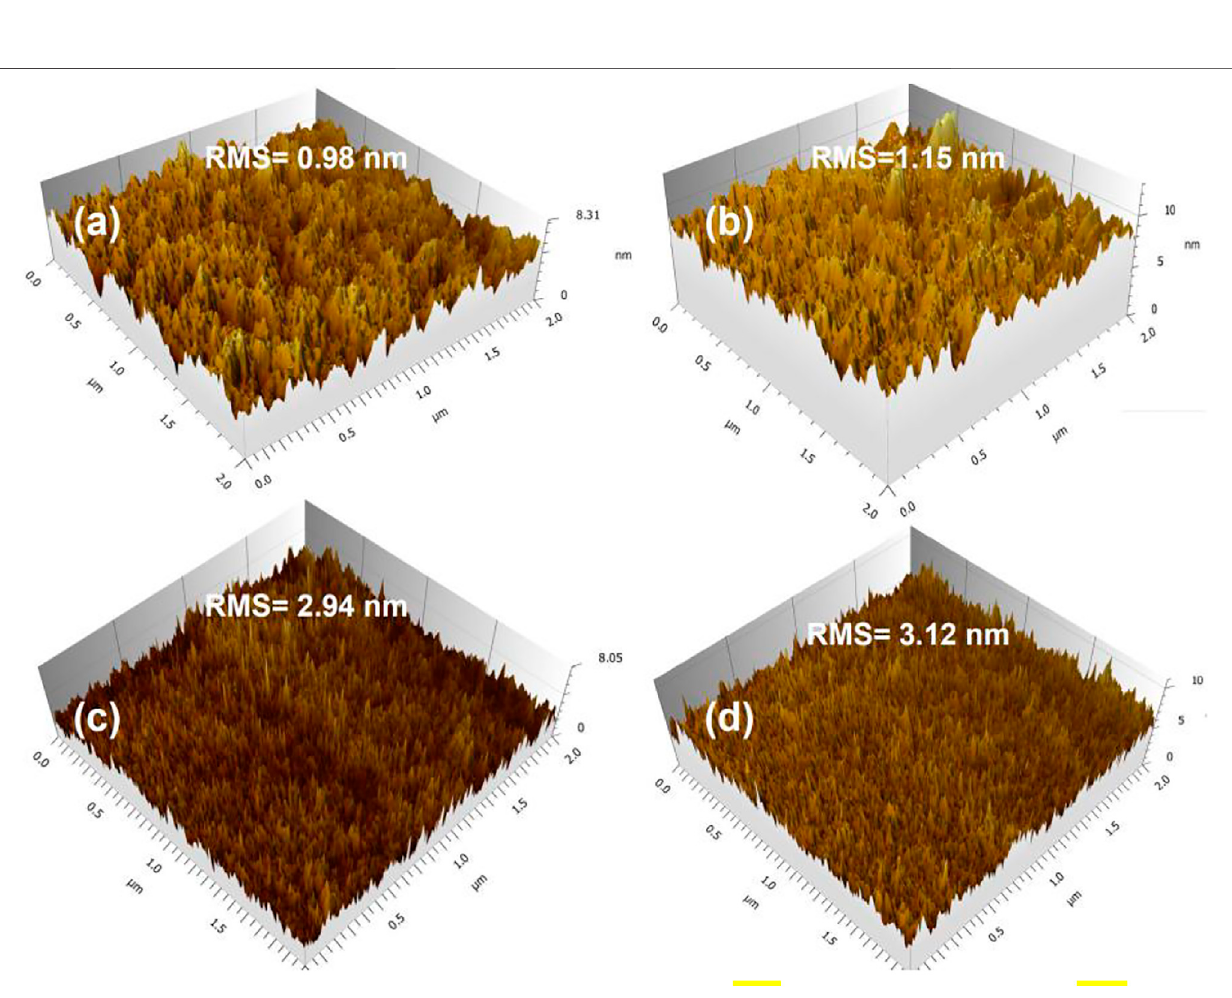
Frontiers in Chemistry |